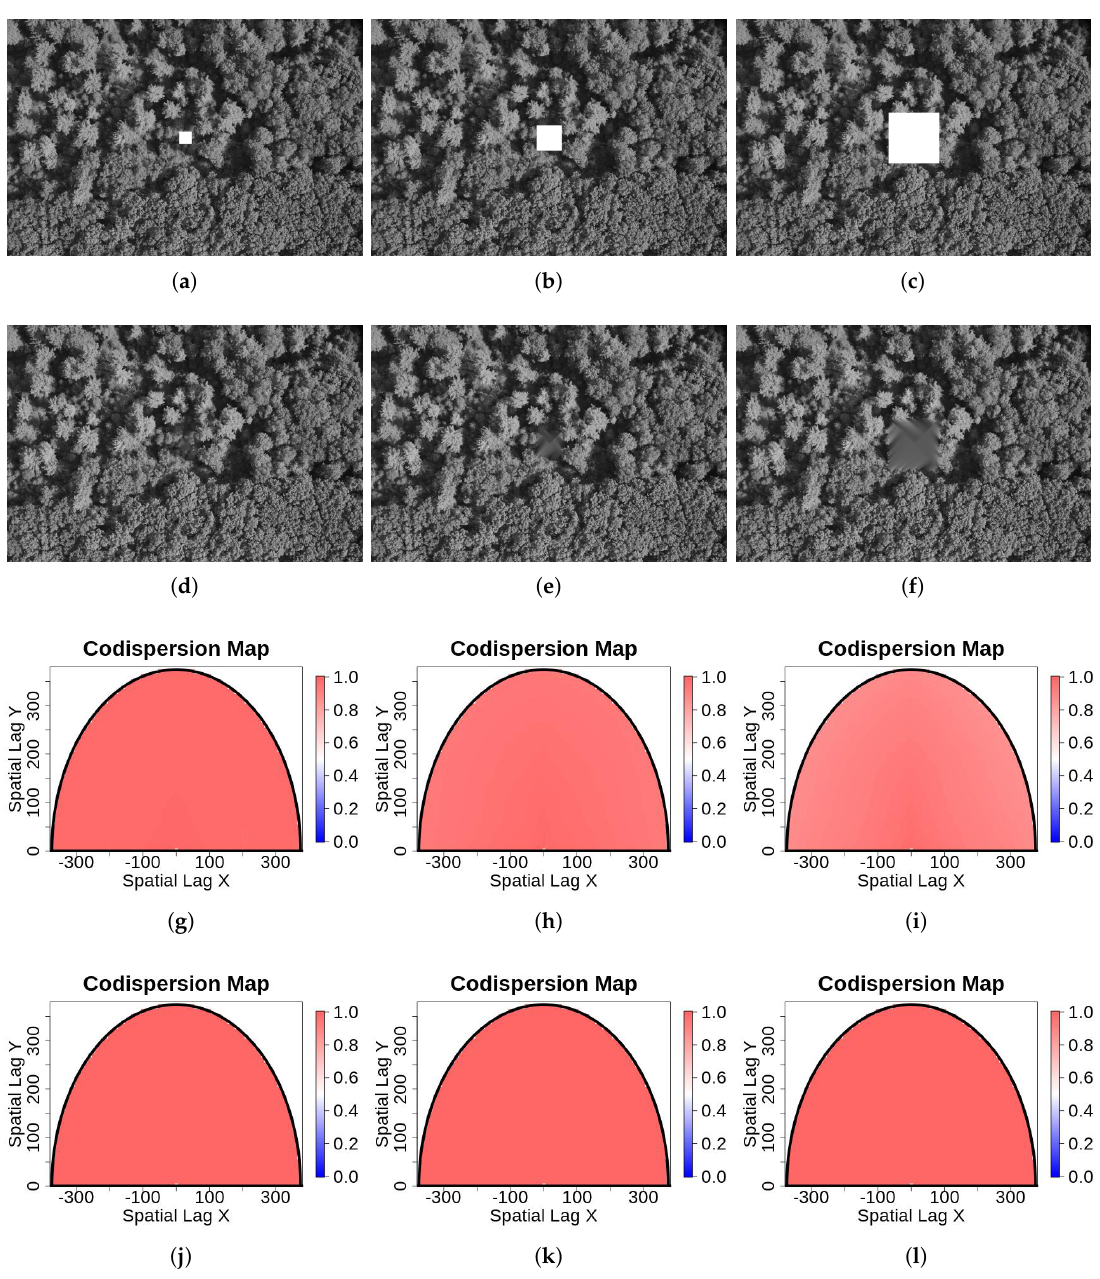
Figure 10. Contamination of the reference Figure 1a by gaps resulting from clusters of missing observations. Images ( a – c ) contain only one missing block in the center of the image of sizes 200 × 200, 400 × 400, y 800 × 800, respectively. These missing data were filled in images ( d – f ) using the imputation algorithm described in the Appendix. Images ( g – l ) are the corresponding codispersion maps between Figure 1a and the imputed images ( d – f